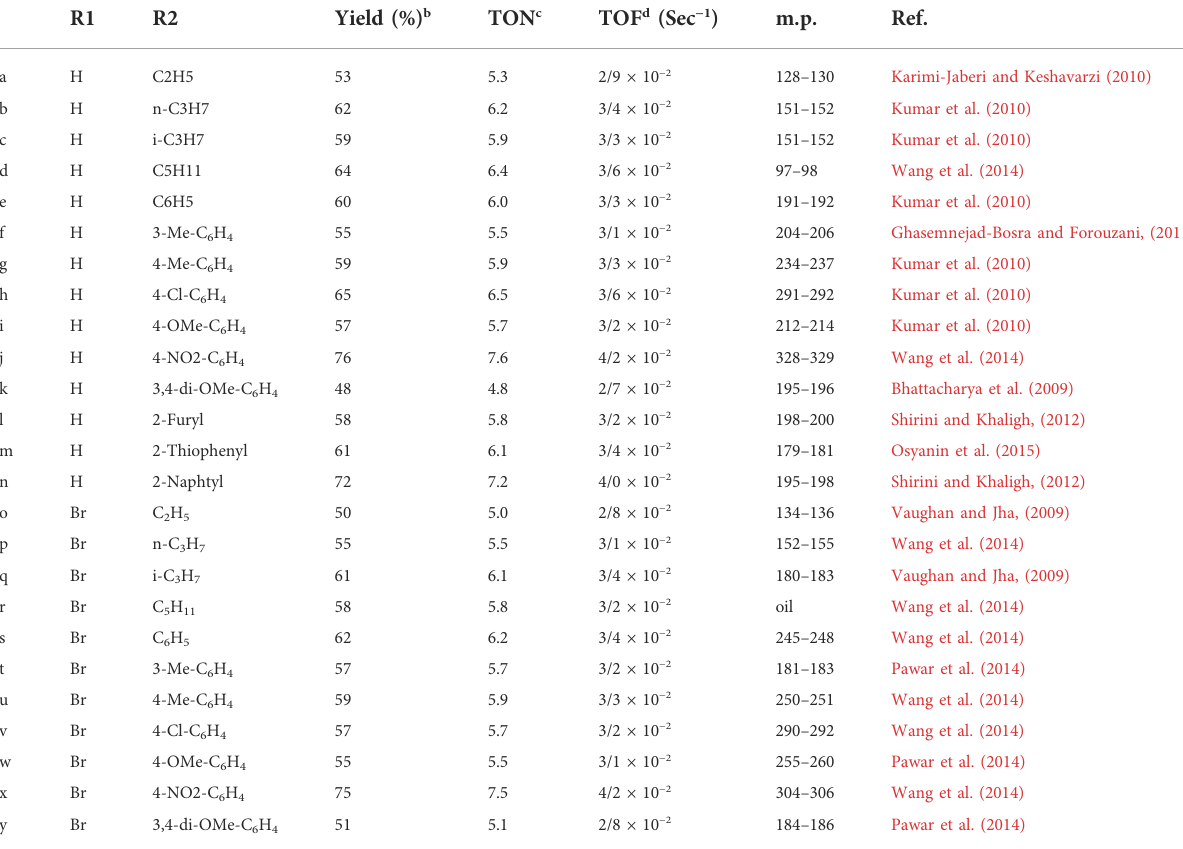
TABLE 2 Yield, TON, TOF, melting points, and references for the prepared 14H -dibenzoxanthene